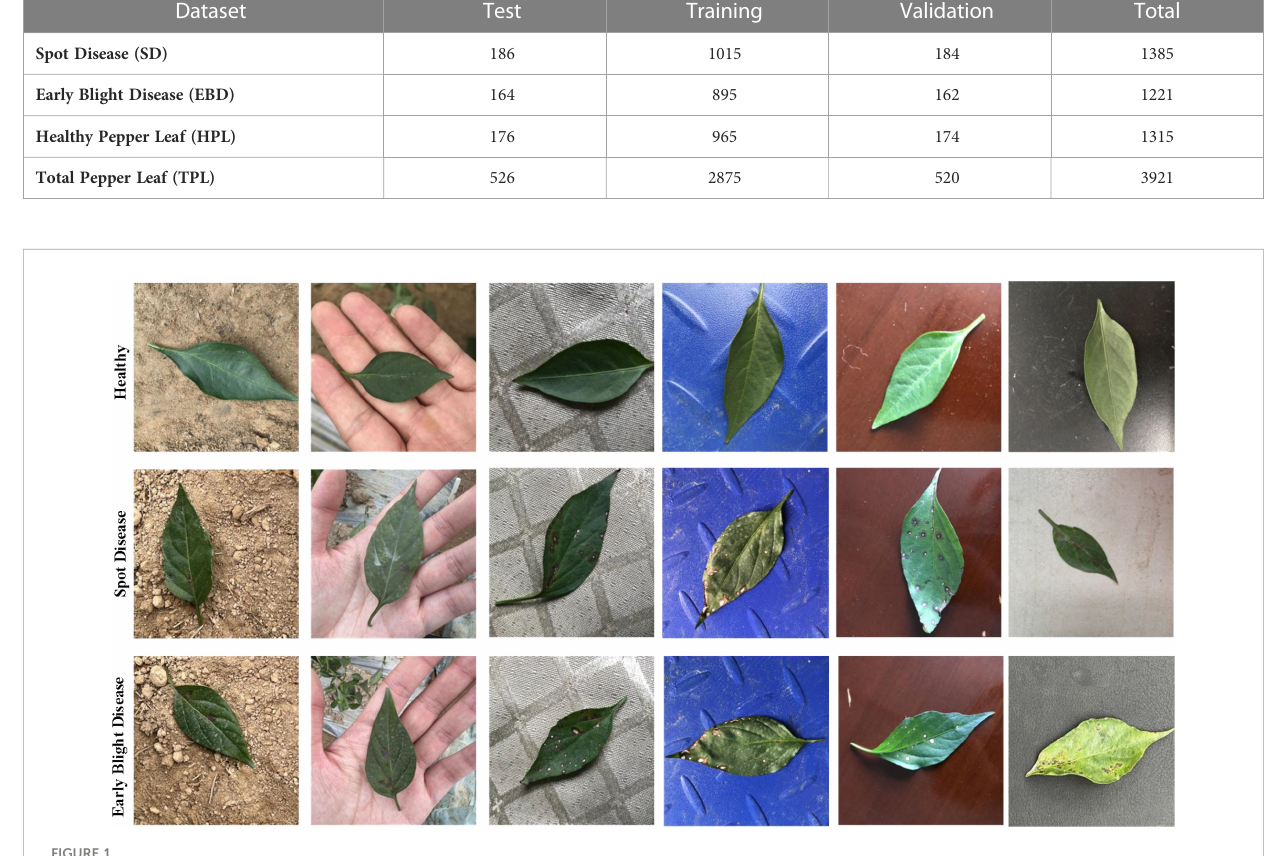
FIGURE 1 The sample dataset with different